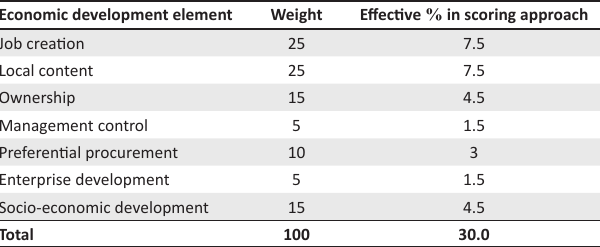
TABLE 1: Socio-economic criteria for the renewable energy independent power producer procurement programme. Economic development